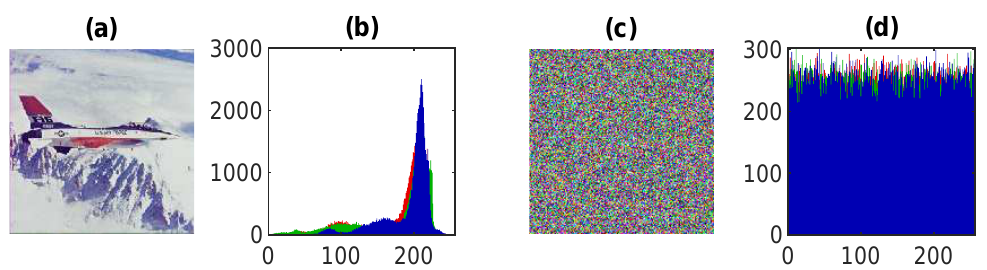
Figure 7. Histogram analysis of grayscale image: ( a ) input image, ( b ) histogram of input image, ( c ) encrypted images, ( d ) histogram of encrypted image.